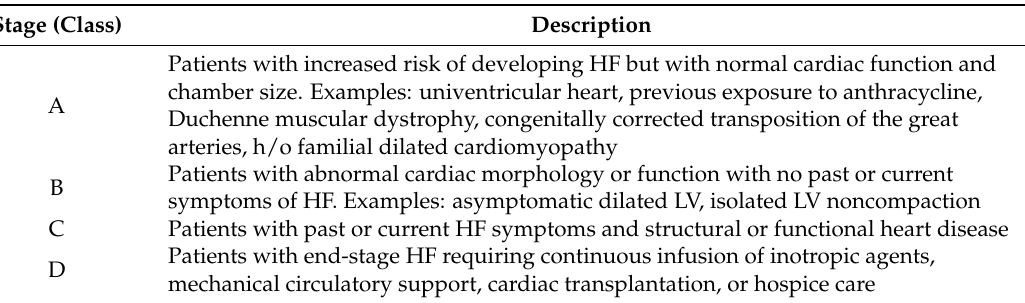
Table 1. Heart failure staging in